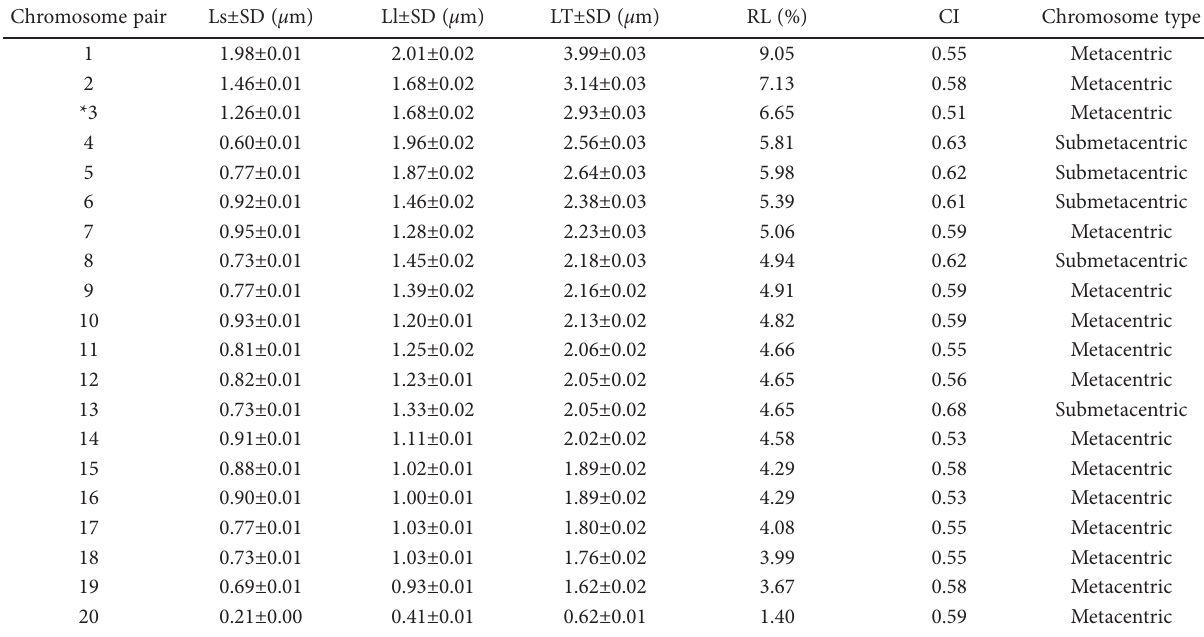
Table 7. Mean length of short arm chromosome (Ls), long arm chromosome (Ll), total arm chromosome (LT), relative length (RL), centro- meric index (CI) and standard deviation (SD) of RL, CI from 20 metaphases of Ho. griffithii (2 n =40). Chromosome